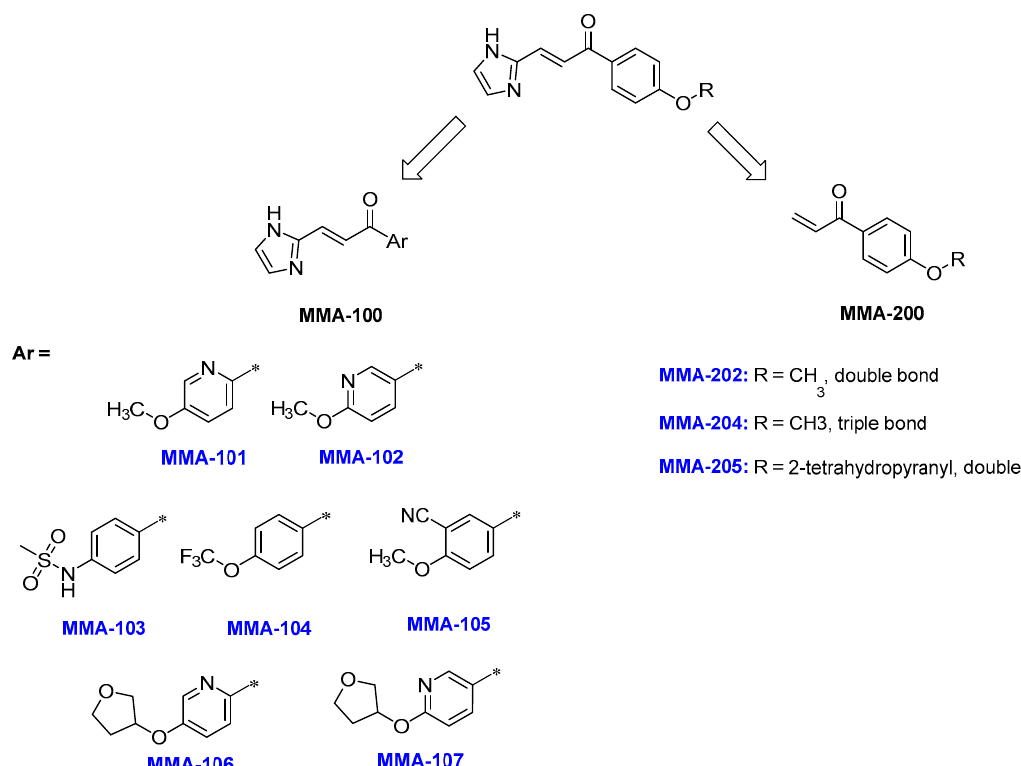
Figure 2. Design of new Michael Addition compounds as hemoglobin modifiers.